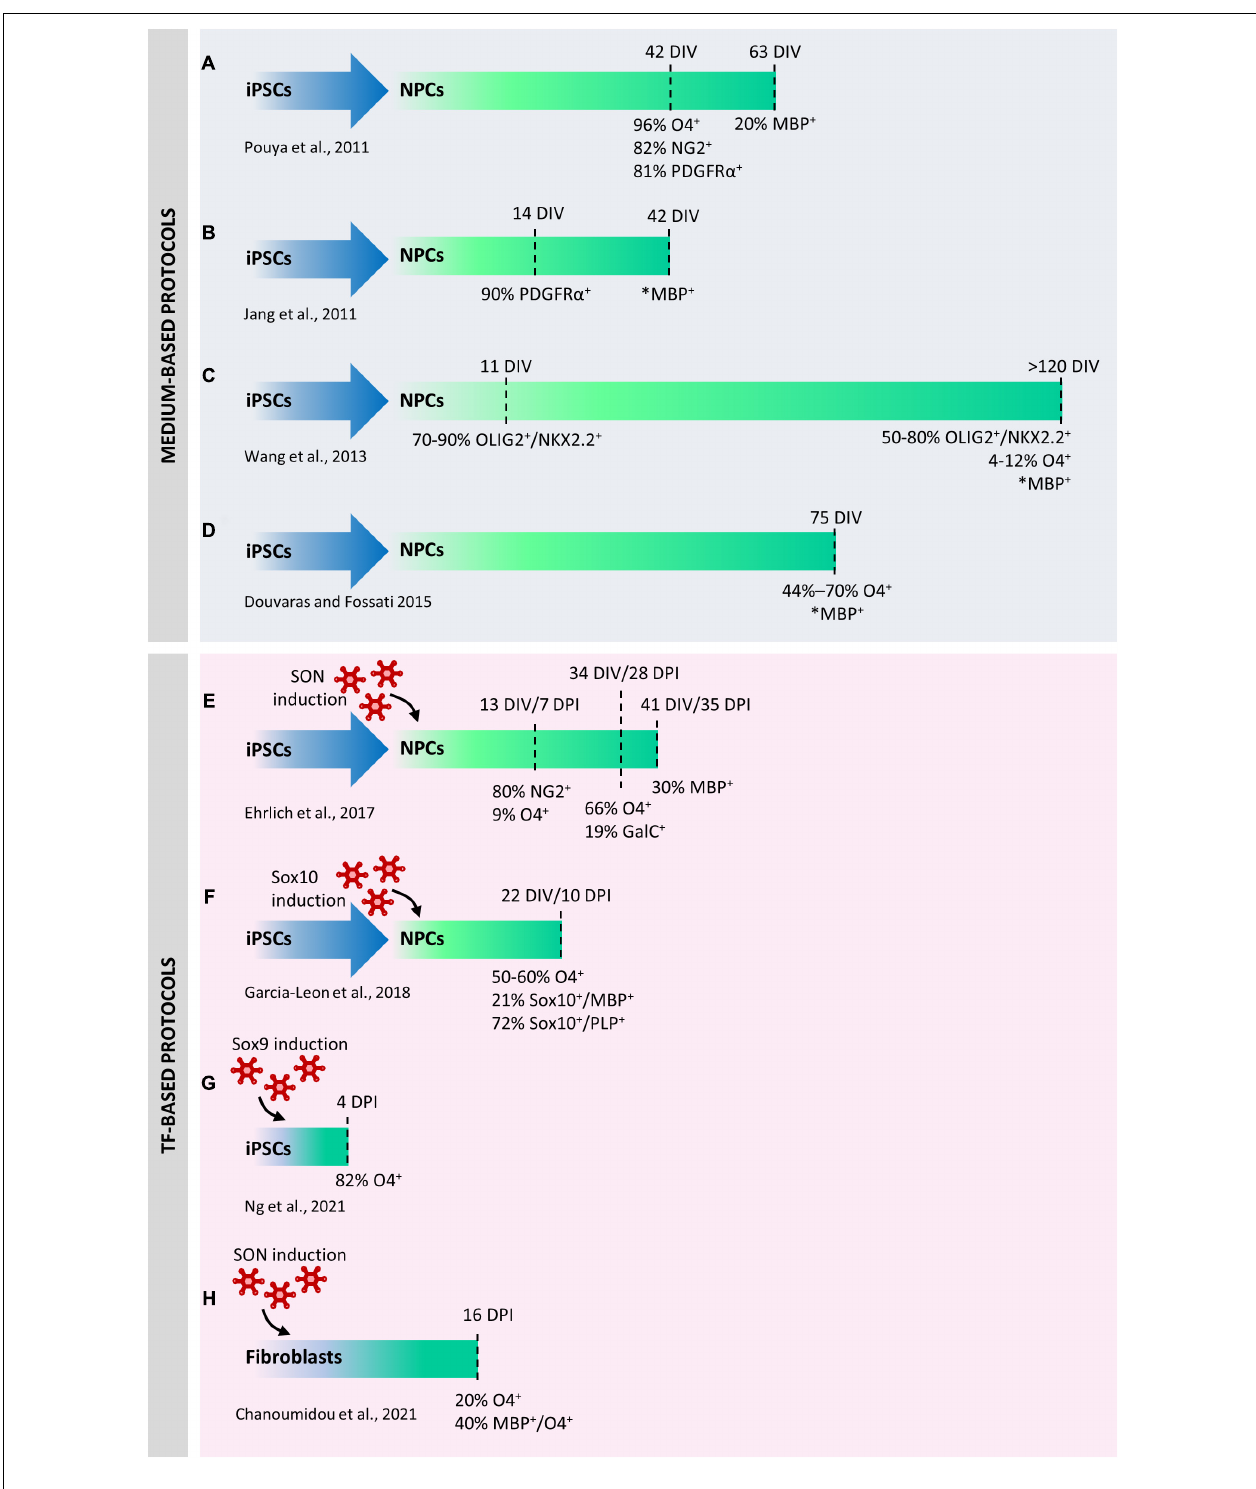
FIGURE 2 | Comparison between protocols used to differentiate human induced pluripotent stem cells (iPSCs) into oligodendrocytes (iOLs). The first published protocols were exclusively based on chemically defined media supplemented with mitogens or differentiation promoting factors (A–D) . Medium-based protocols were progressively refined to increase their robustness and reproducibility in a higher number of lines. Direct differentiation by ectopic expression of selected transcription factors has significantly accelerated the differentiation of neural precursor cells (NPCs) into iOLs and increased the reprogramming efficiency (E–G) . In one case, direct conversion of iPSCs into iOLs has been described (H) . DIV, days in vitro ; DPI, days post induction. *Percentage not available.